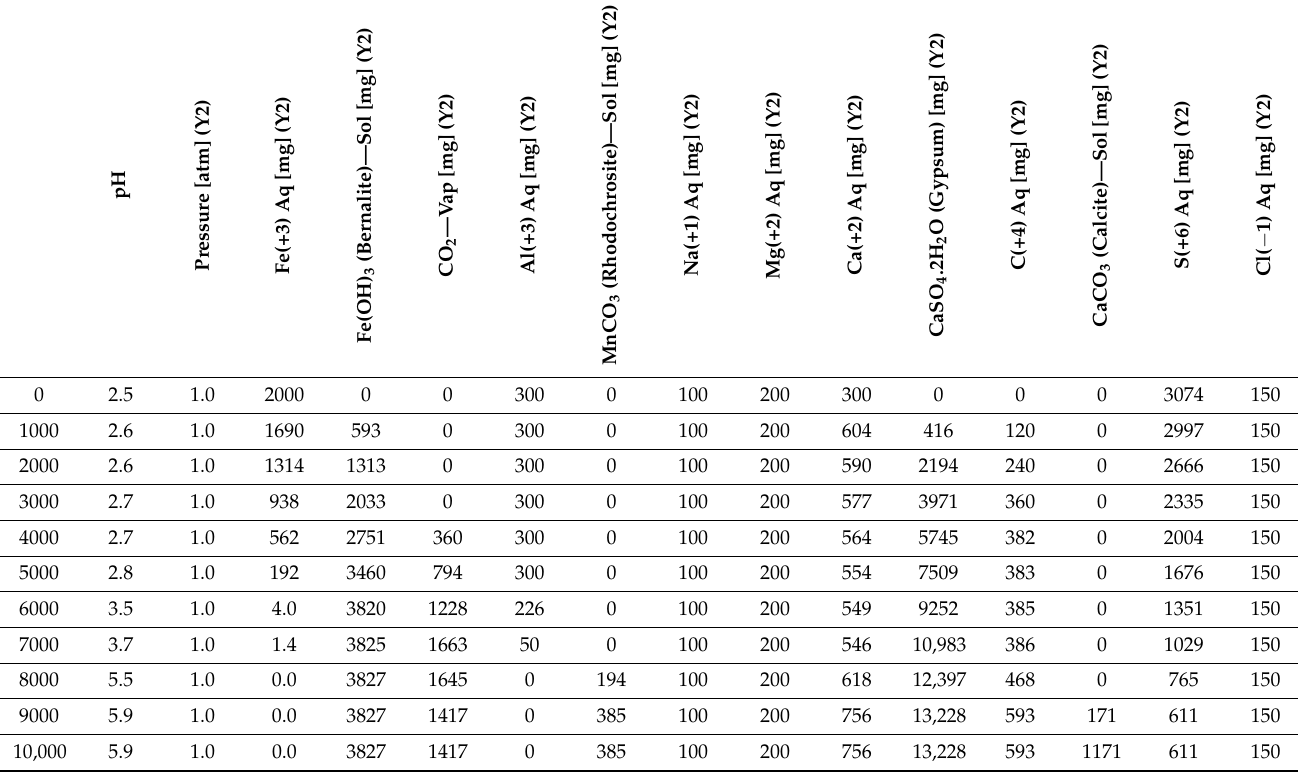
Table 4. Removal of Fe 3+ and other metals with only CaCO 3 at 1 atm (OLI